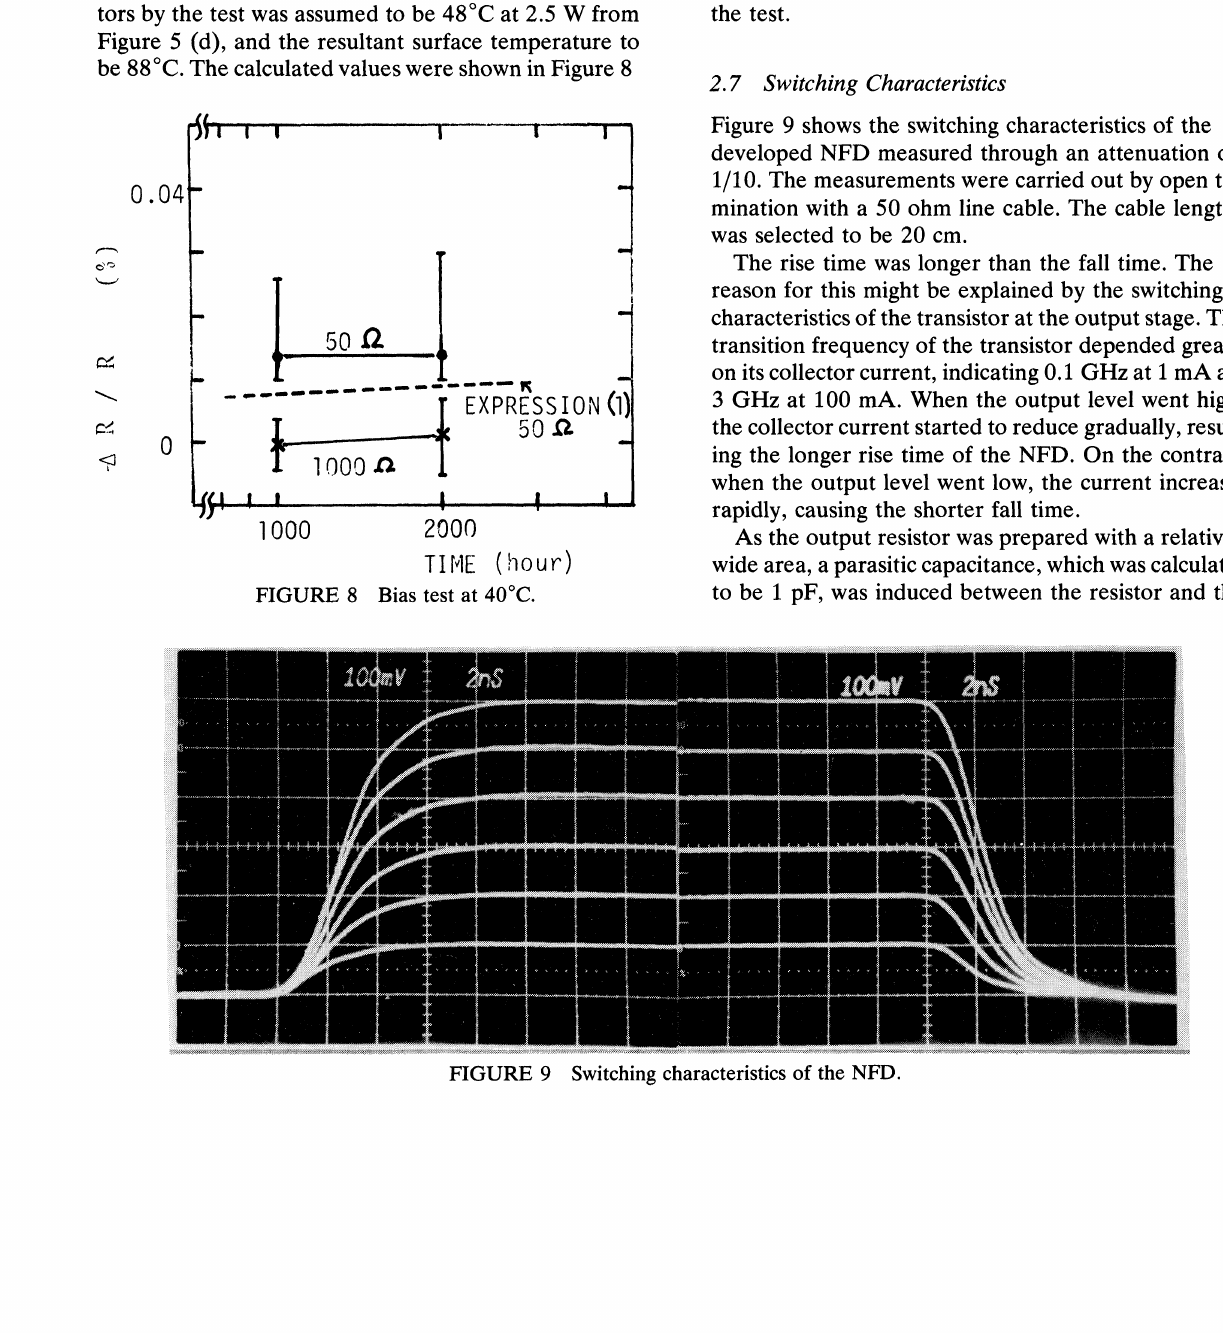
FIGURE 9 Switching characteristics of the